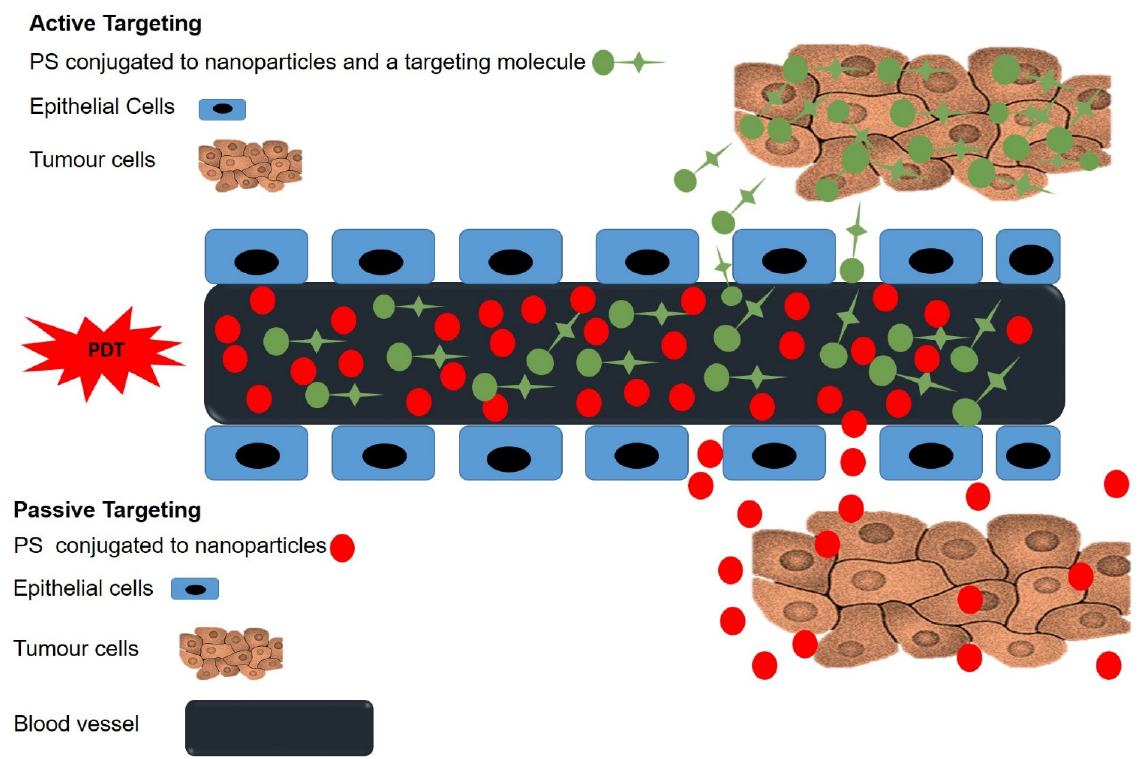
Figure 3. Passive and active targeting mechanisms in PDT. Passive uptake of PSs is facilitated by the EPR effect, while active uptake of PSs involves targeting moieties, which have specific affinity for tumor cell antigens.